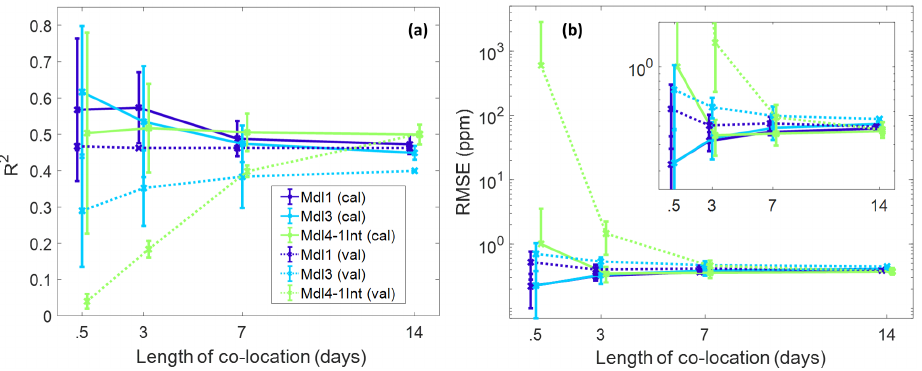
Figure 11. R 2 (a) and RMSE (b) for the calibration model generation (based on a given length of time) and the application of those models to the complete Colorado data. Note that calibration data, or training data, are selected using a random stating point in the complete Colorado dataset and the appropriate amount of consecutive data. The colors indicate the model, and solid lines indicate calibration results while dashed lines indicating validation